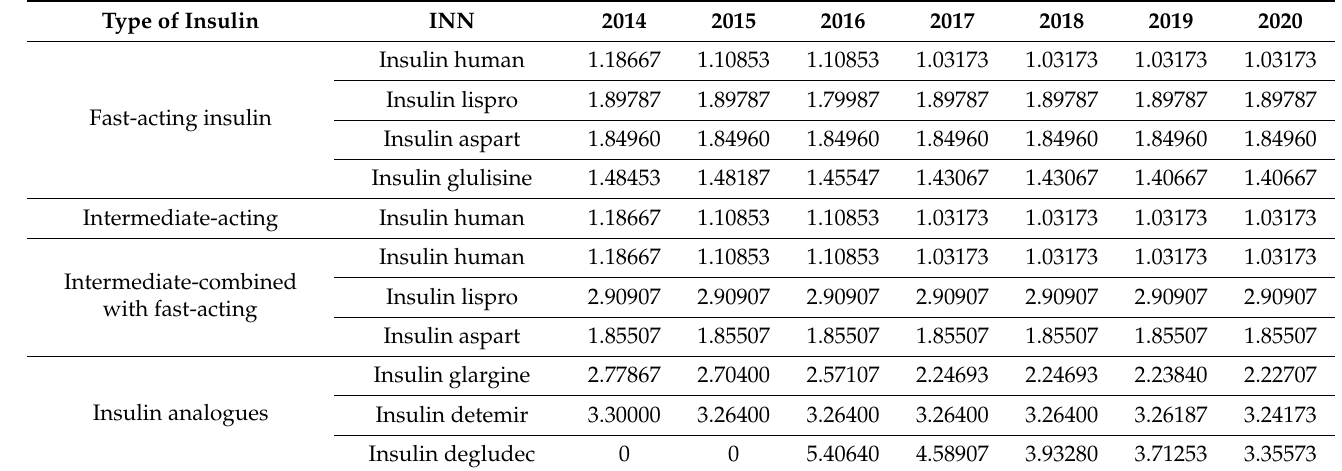
Table 2. Reference price per DDD of INNs of insulins approved in